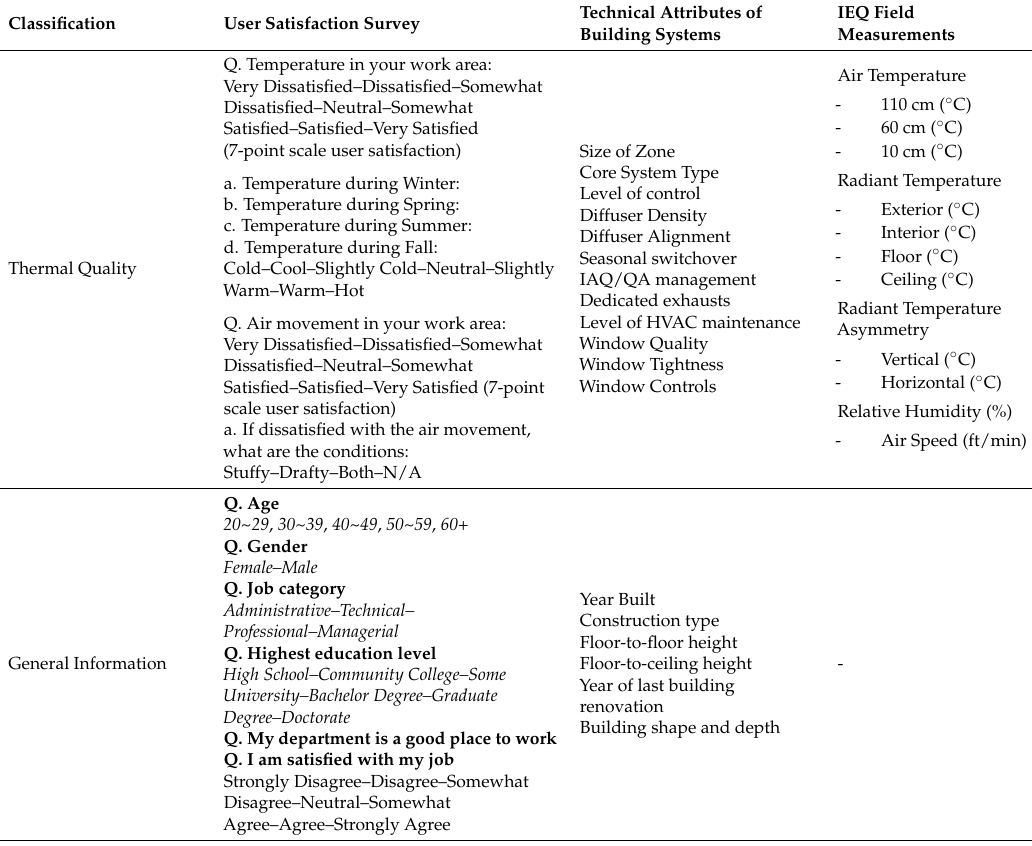
Table 2. Illustration of variables assigned to a single workstation (Thermal